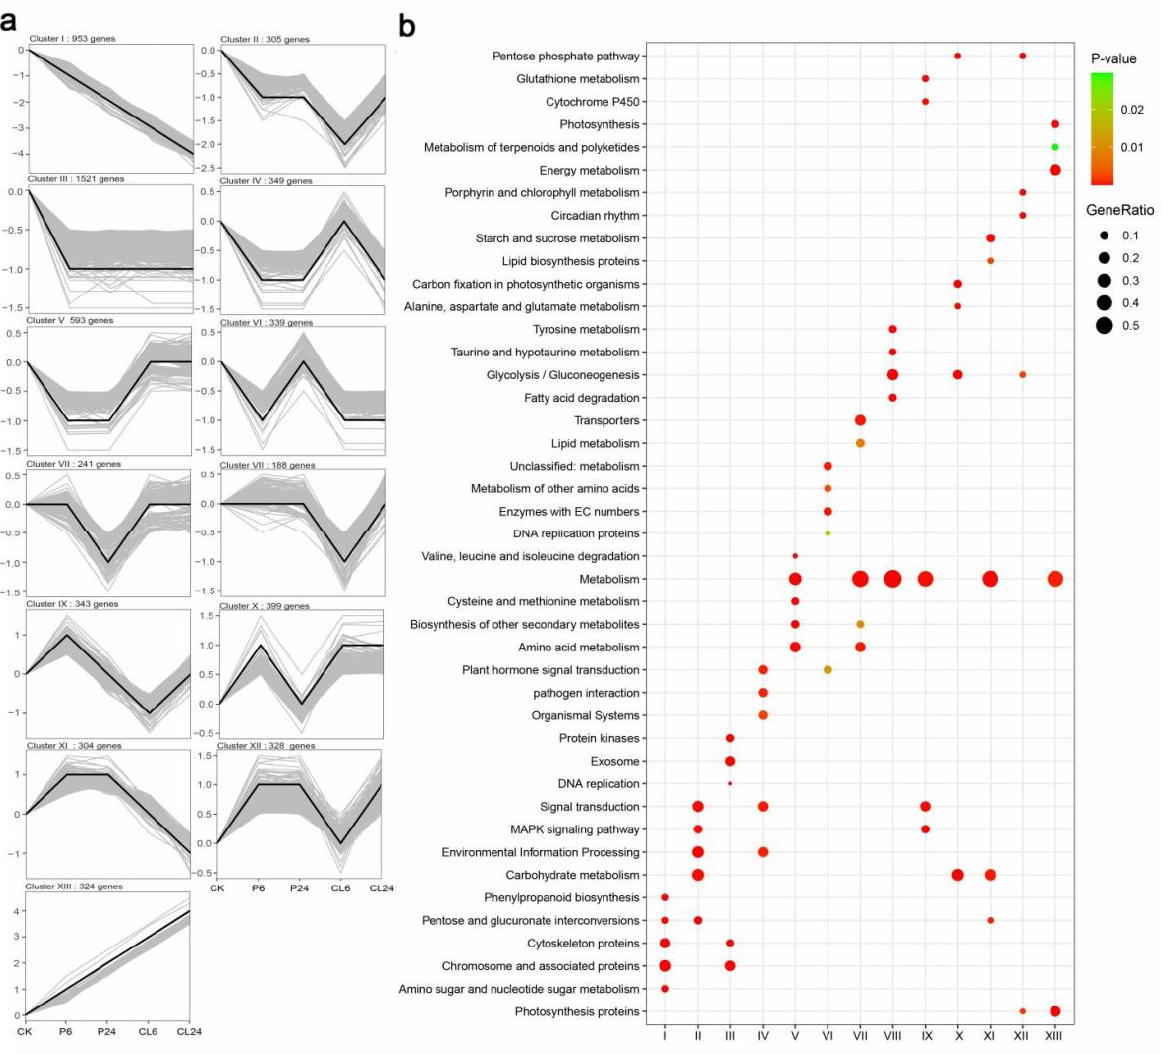
Figure 3. Transcript abundance of DEGs under salt or drought stress. ( a ) Clustering analysis of the DEGs into 13 clusters according to their expression profile. The number of unigenes for each cluster are indicated. ( b ) Comparison of the KEGG enrichment of gene clusters. The size and color of the dots represent the gene ratio and the range of the p -value, respectively. Gene ratio refers to the ratio of the number of target genes associated with a KEGG pathway to the total number of genes in the pathway.